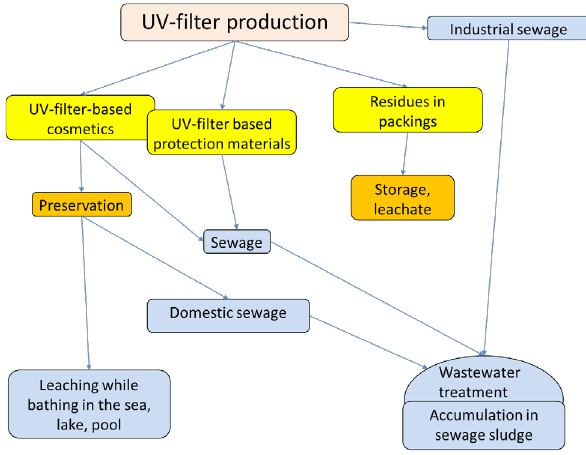
Figure 4: Ways of migration of components of the UV filters into the environment